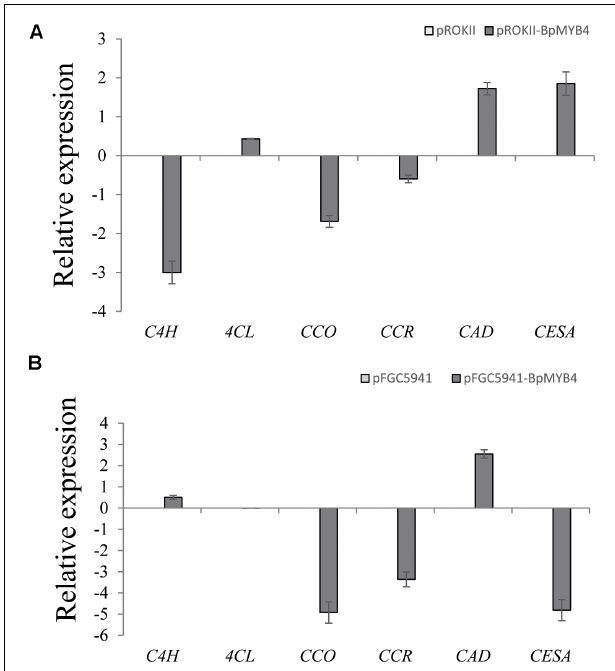
FIGURE 9 | The expression levels ofcell wall biosynthesis-related genes in overexpression and suppression of expression in birch. (A) Taking the empty vector strain (pROKII) as a control, the expression levels of cell wall biosynthesis-related genes in overexpressing strains were monitored. (B) Taking the empty vector strain (RNAi) as a control, the expression levels of cell wall biosynthesis-related genes in the suppressive expression line were